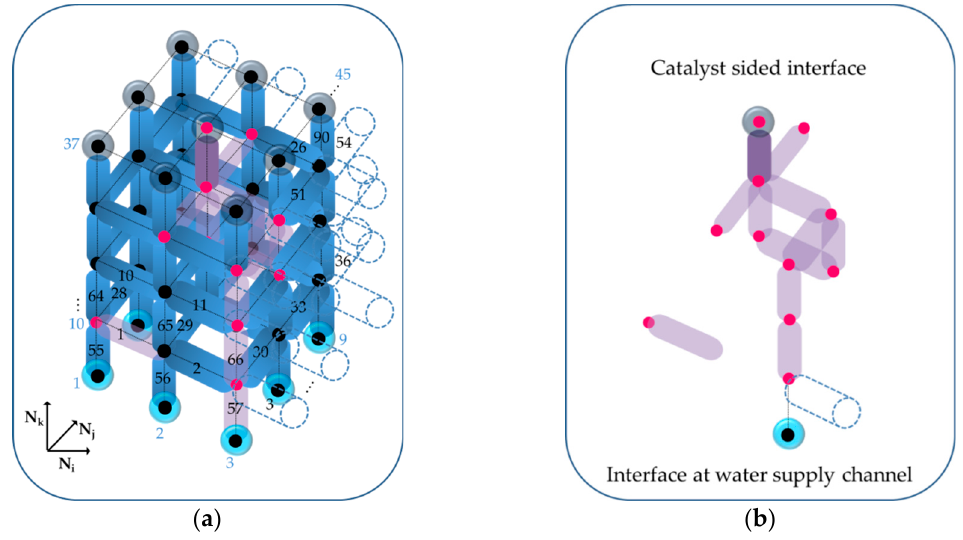
Figure 1. ( a ) Schematic illustration of the pore network model (PNM) of drainage with pore and throat numbering (pore numbers in blue; throat numbers in black). ( b ) Breakthrough path of oxygen from the catalyst side to the water supply channel. Note the periodic boundary conditions that allow connection of edge throats and pores with each other.